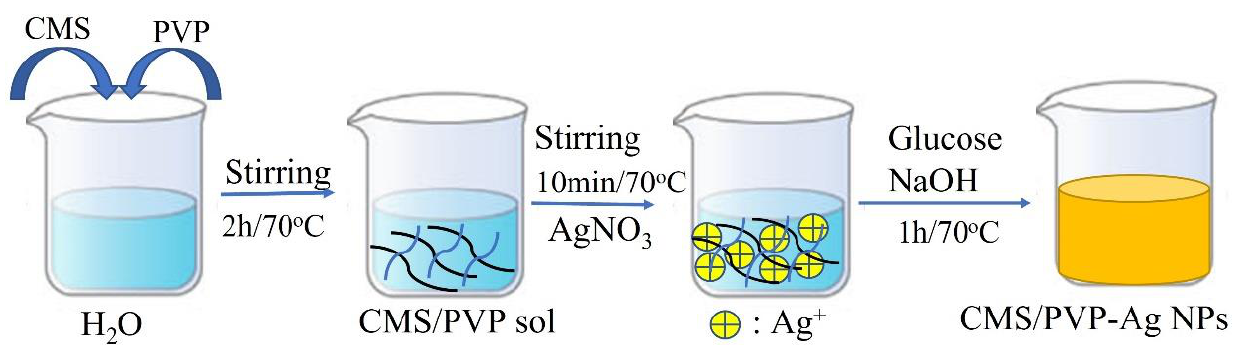
Scheme 1. Schematic illustration for the preparation of CMS/PVP-Ag NPs.